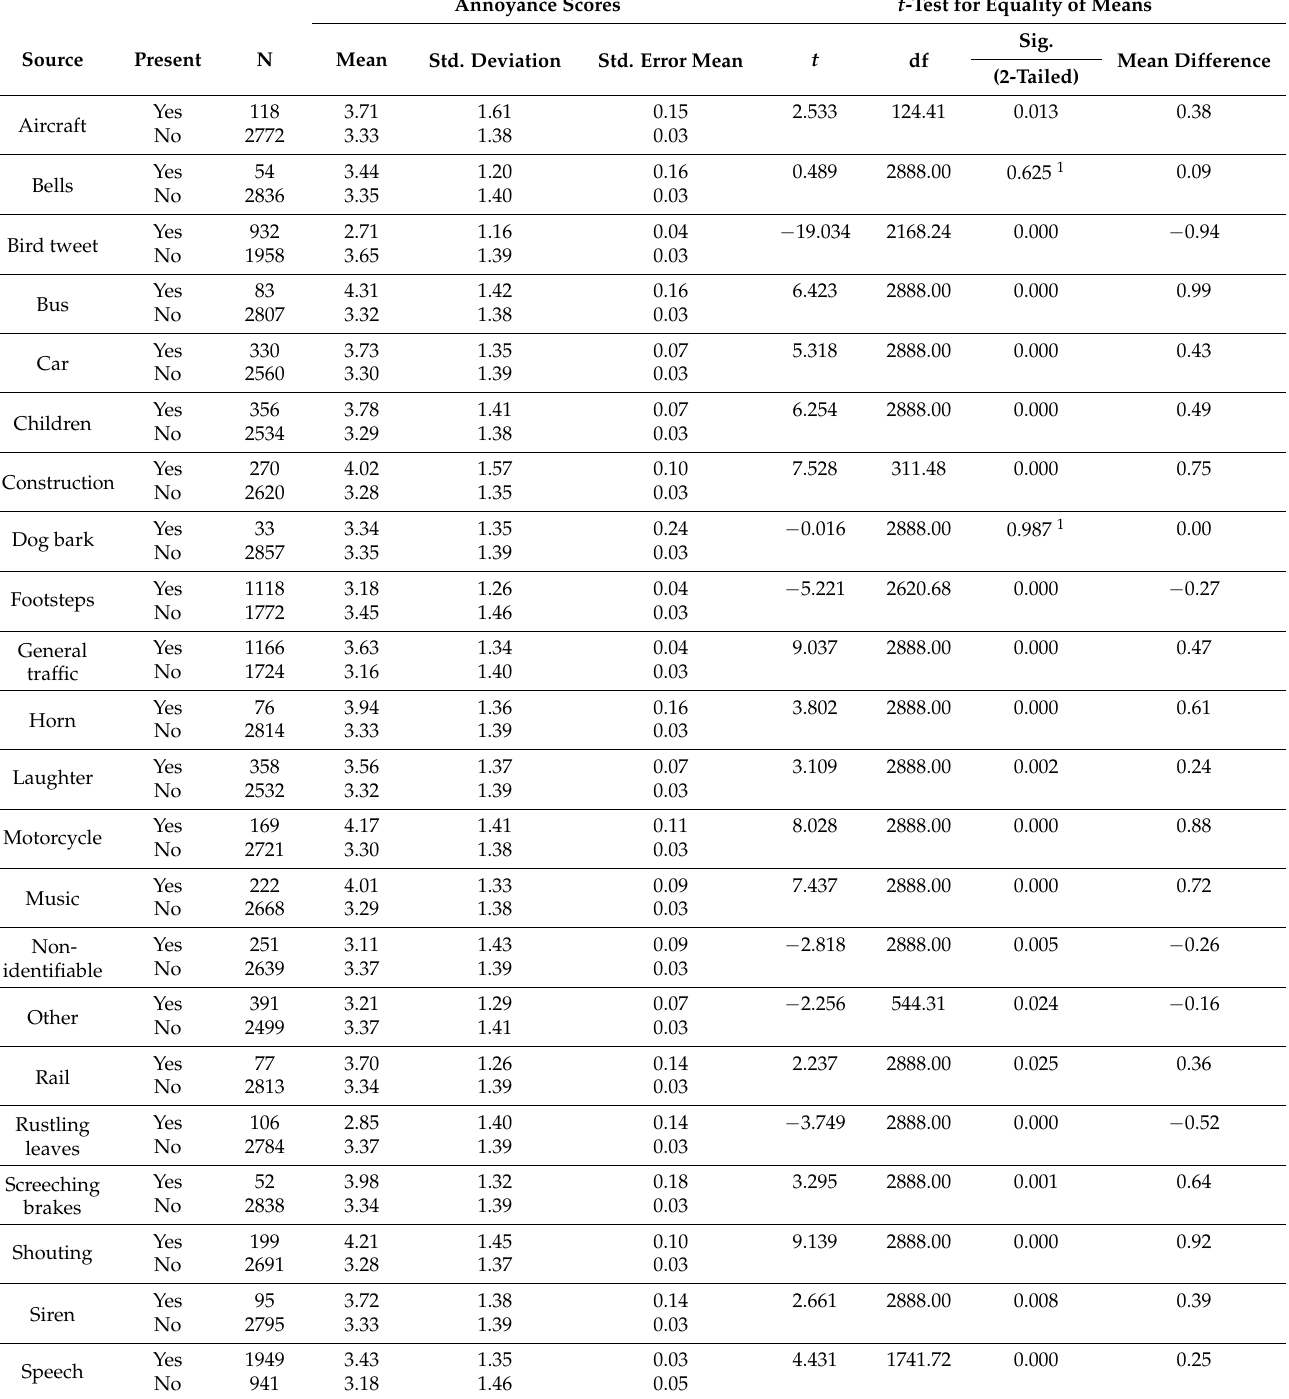
Table 1. Descriptive statistics for the annoyance scores for each sound source and t -tests for each sound source between the groups when the source is present and when it is